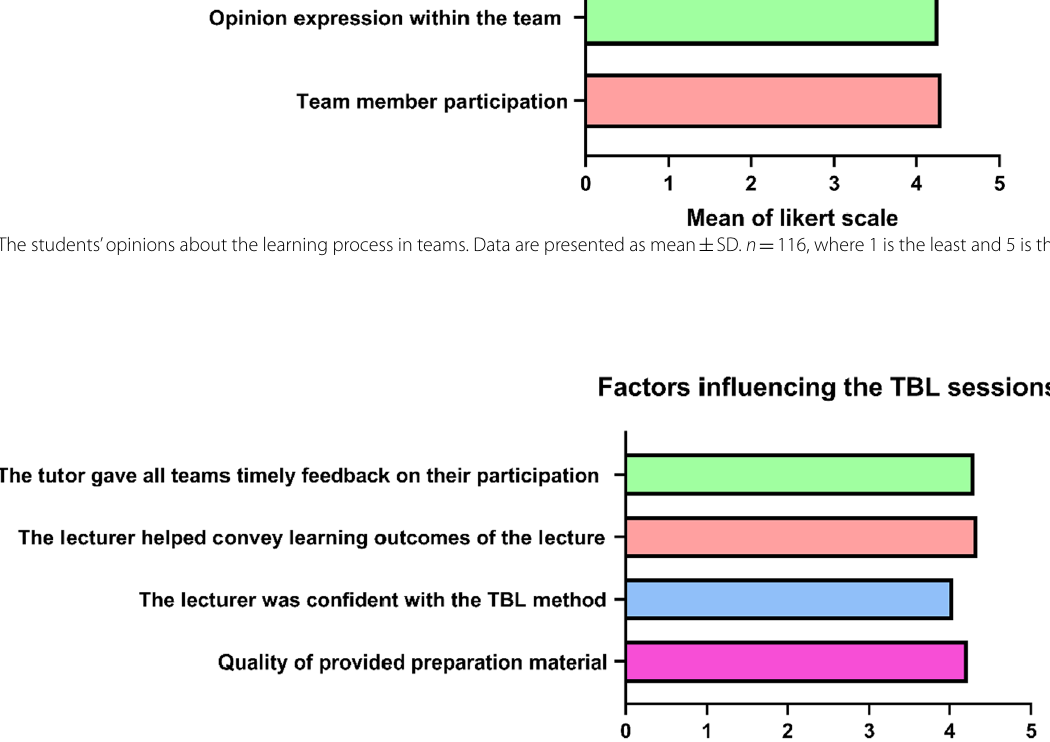
SD. n 116. TBL: Team-based learning, where 1 is the least and 5 ± =